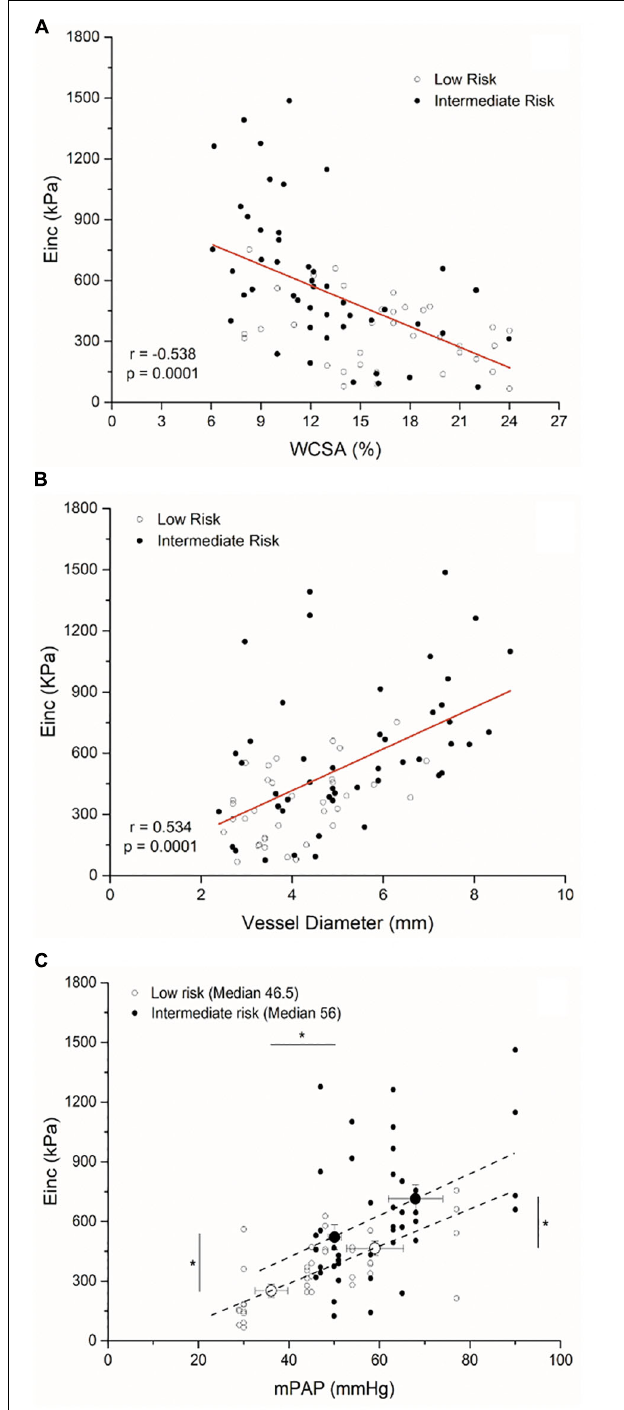
FIGURE 5 | Scatter plot between the incremental elastic modulus (Einc) and the relative wall cross-sectional wall (WCSA) (A) , the vessel diameter (B) , and the mean pulmonary arterial pressure (mPAP) (C) of all PA segments interrogated ( n = 37 low-risk patient segments; n = 48 intermediate-risk patient segments). (* P < 0.05 differences between low-risk and intermediate-risk patients of the Einc and mPAP below and above the median values,